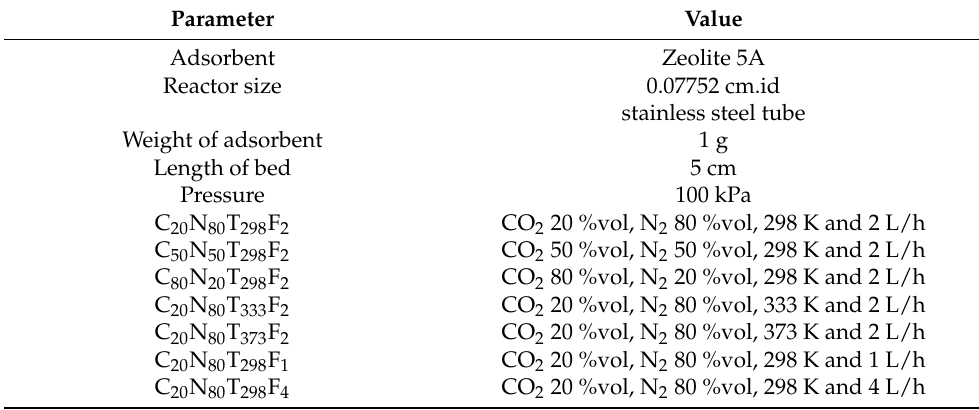
Table 1. Information data for CO 2 adsorption from CO 2 /N 2 gas mixture on zeolite 5A. Parameter Value